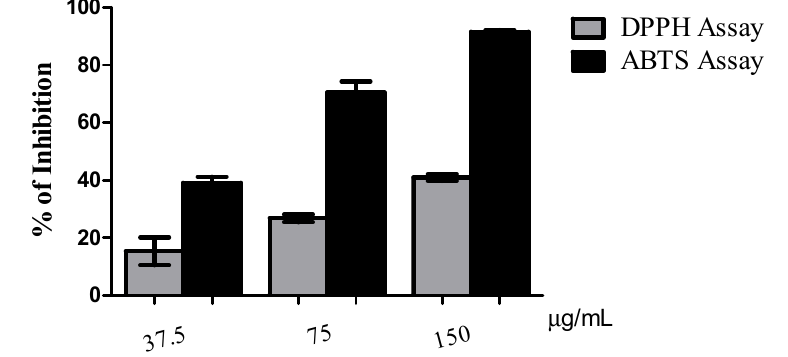
Figure 5. Percentage of inhibition of DPPH • and ABTS • + radicals remaining after 120 min of reaction in the presence of nitrated POPS at the three concentrations tested (37.5, 75 and 150 µg/mL in ethanol).